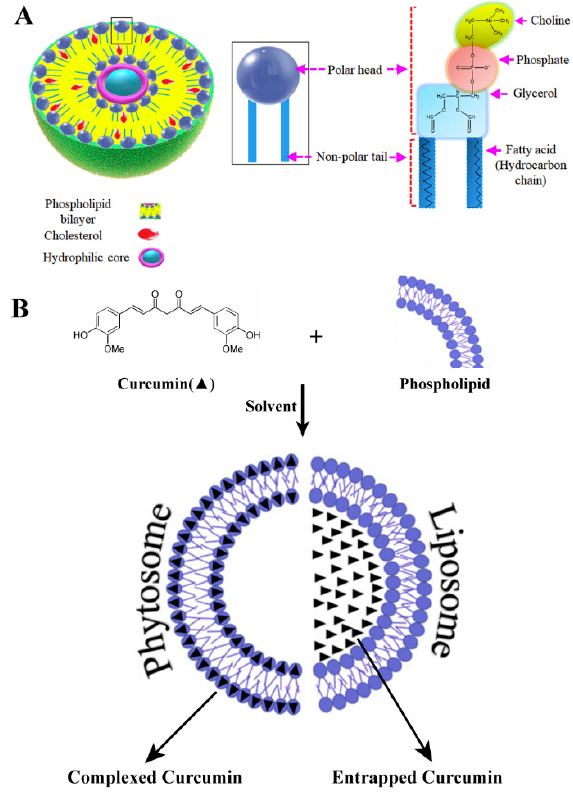
Figure 3. Liposome structure and drug loading diagram: ( A ) Cross-section structure of liposome, made of phospholipid and cholesterol, showing the magnified molecular structure of a phospholipid that consists of a polar head and a non-polar tail. Phospholipid head is hydrophobic and comprises choline, phosphate and glycerol, while the tail is a hydrocarbon chain that shows lipophilicity. ( B ) A schematic representation of the structure and preparation of phytosomal curcumin. Reprinted from reference [134,159]. Copyright 2016 Elsevier Masson SAS, 2019 Elsevier Ltd.